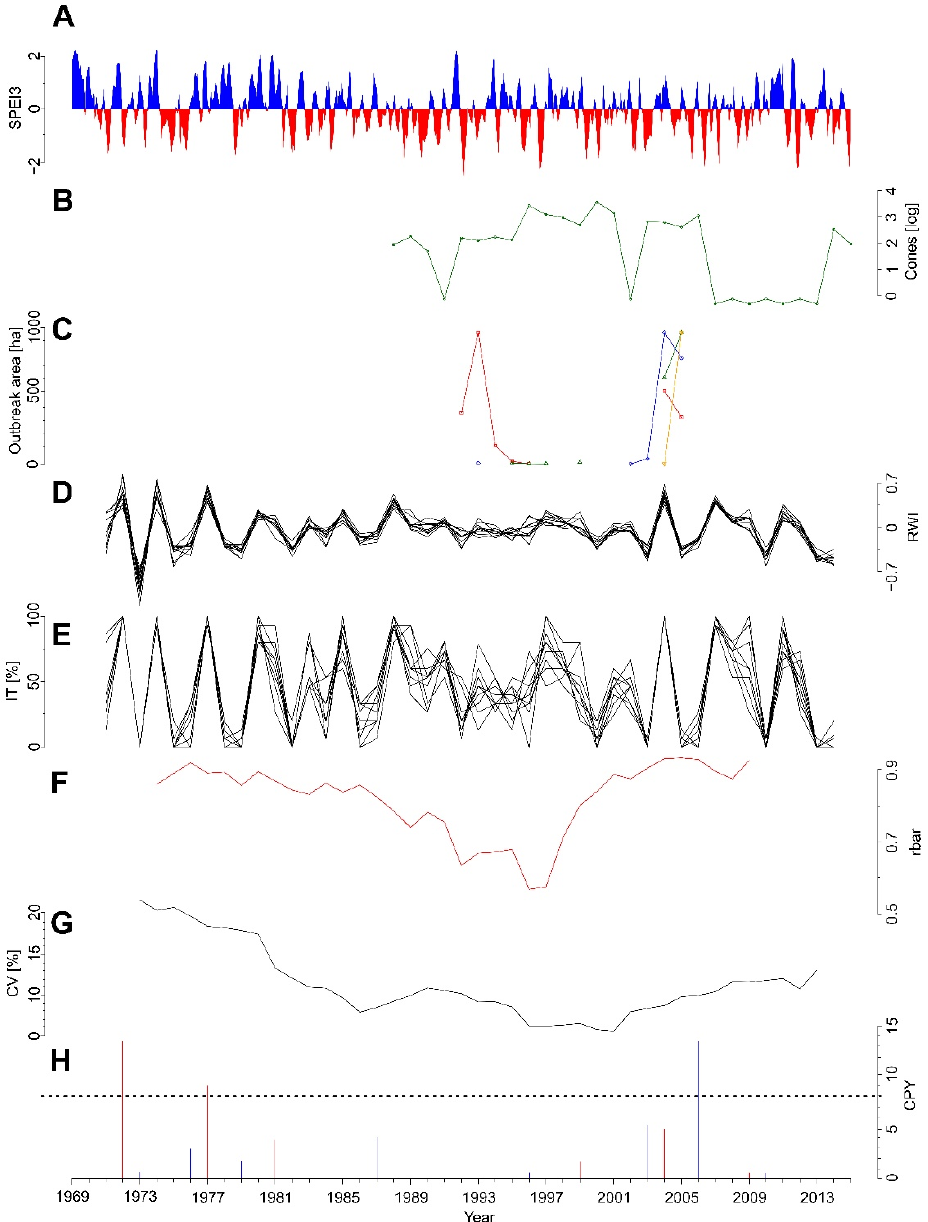
Figure 2. Temporal variations of environmental parameters: standardized precipitation evapotranspiration index (SPEI) integrated over three years ( A ), seed crop magnitude on a logarithmic scale (grey poligon highlights seed years; ( B ) and area of insect outbreak ( Diprionidae —red square, Lymantria monacha —blue diamond, Bupalus piniarius —green triangle, Panolis flammea —yellow triangle point down); ( C ) ring width indices ( D ), interval trend ( E ), 10–year moving window rbar ( F ), 10–year coe ffi cient of variation, ( G ) and common pointer years (red—positive, blue—negative, dashed line—common pointer years; threshold for ( H